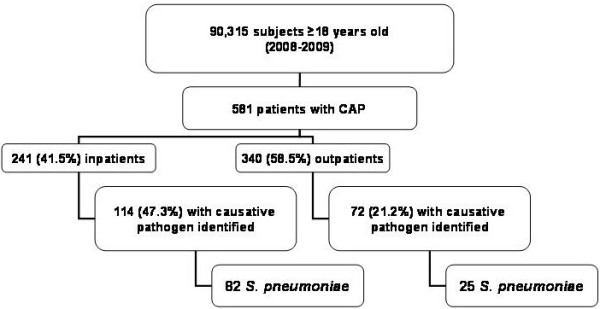
Diagram of patient population.